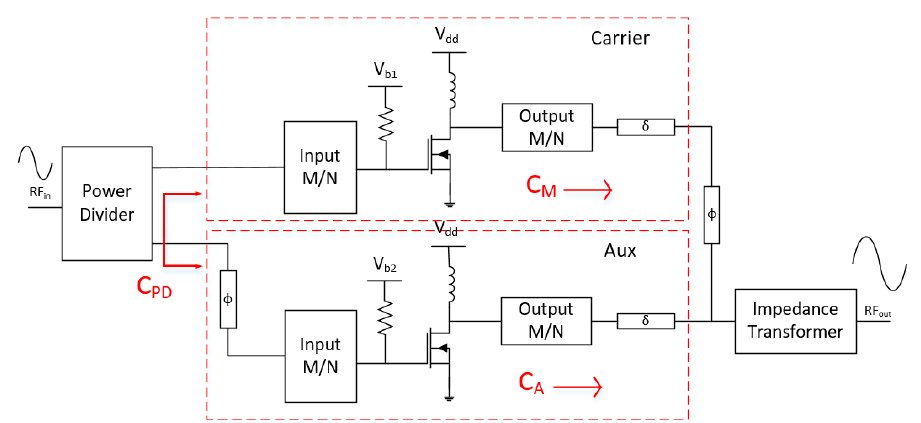
Figure 1. Complexity paths for two-way DPA. The main and auxiliary paths are in parallel.